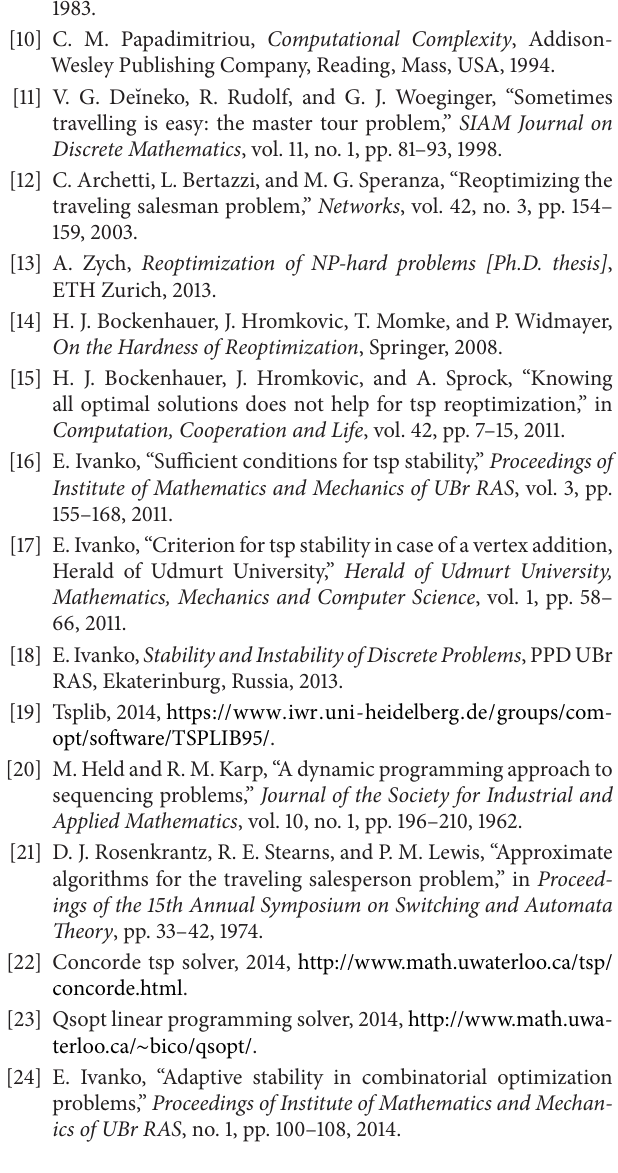
is the cost of the optimal Opt (inpercent),where 𝛽 isobtainedbyAlgorithm 3 CI